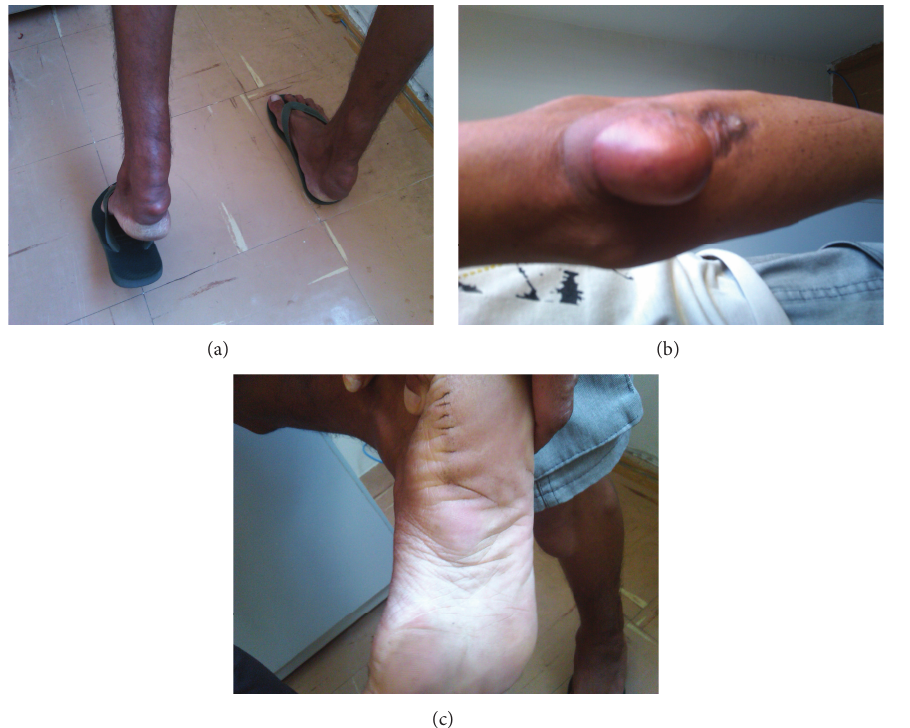
Figure 1: Clinical presentation of the patient. Xanthomas on the heels (a), elbows (b), and soles of the feet